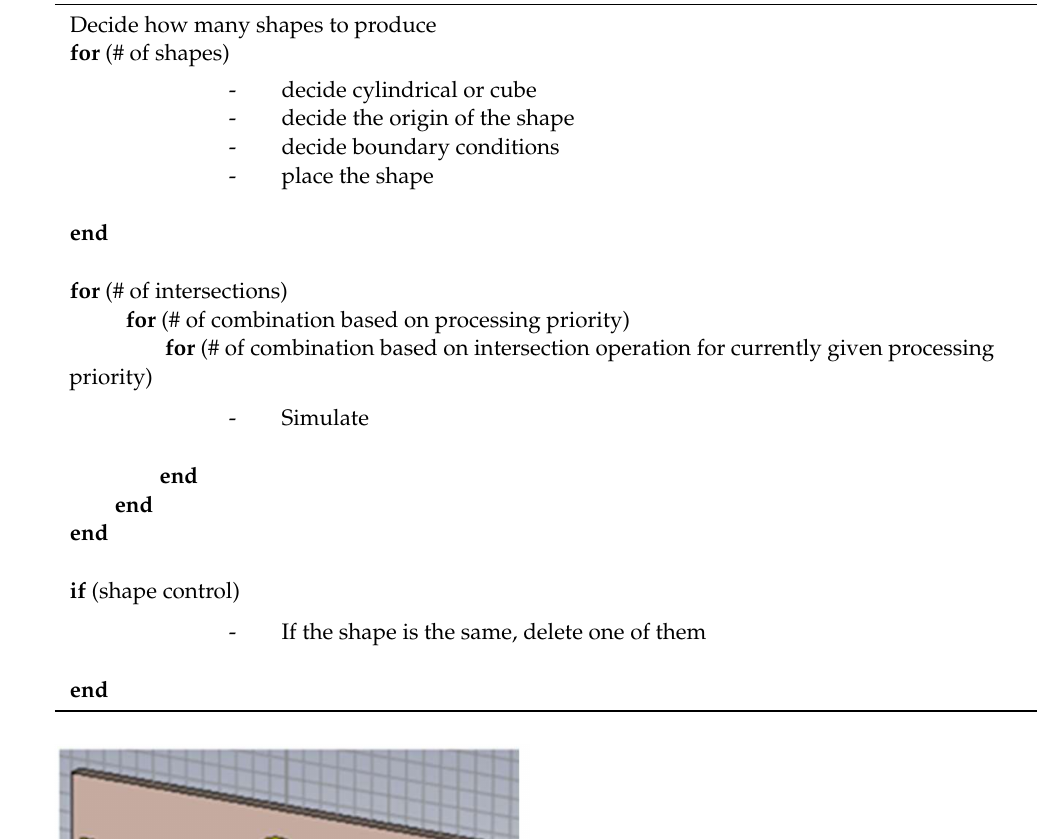
Algorithm 1: Metamaterial’s Shape Generation Process